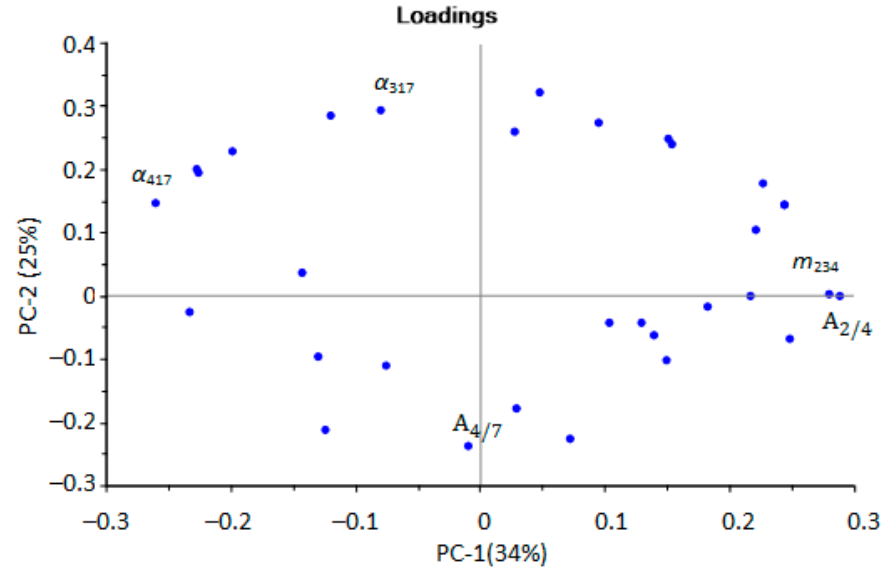
Figure 4. Loadings plot of the PCA model for urine samples by identification parameters (sensor numbers in the subscript correspond to the designations in the Section 2.2.1, the plot with designation of all points in Supplementary materials, Figure S6).